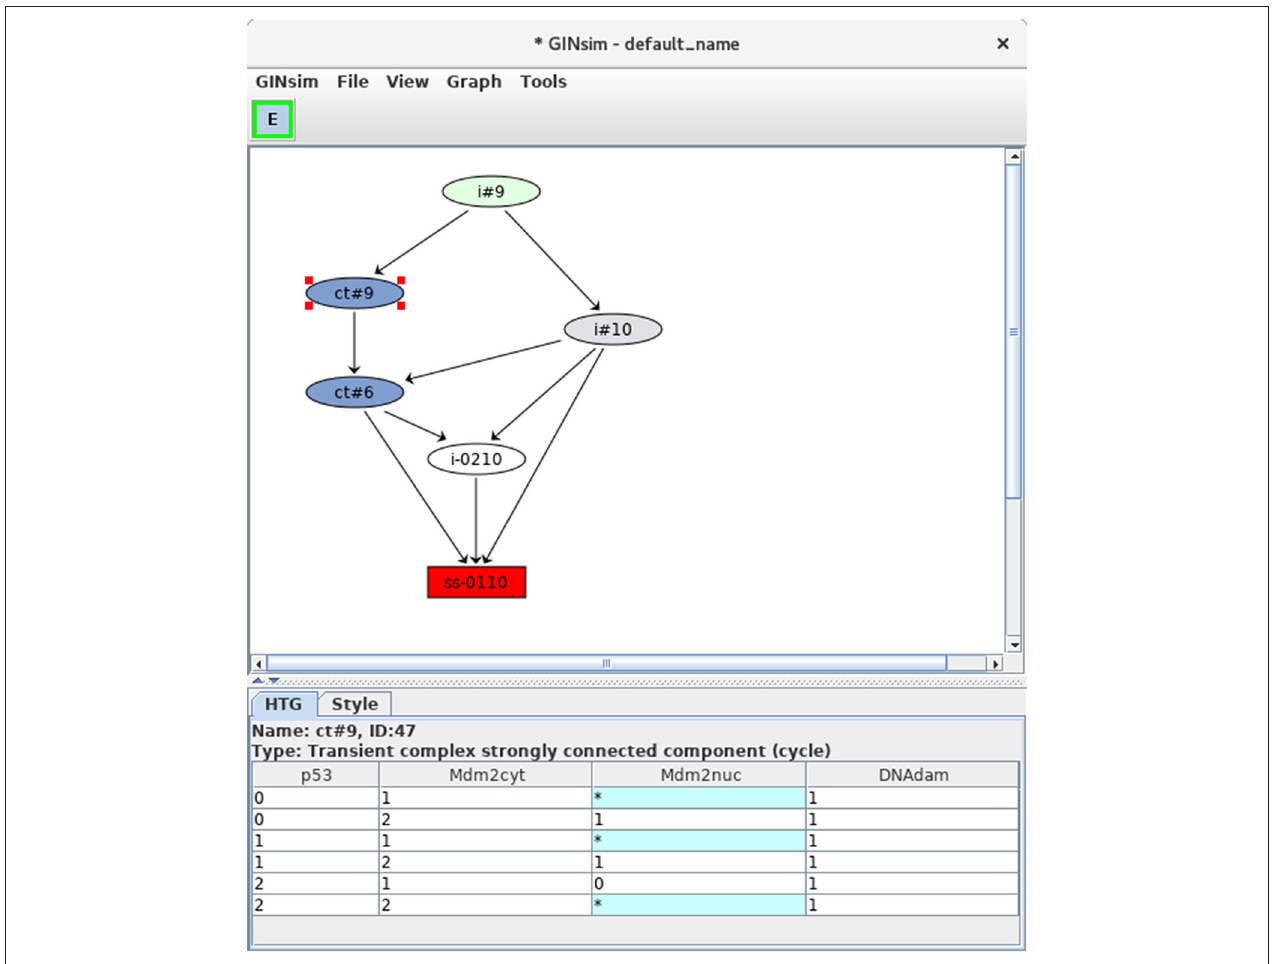
FIGURE 9 | Hierarchical transition graph. The hierarchical transition graph for the complete asynchronous dynamics of the p53-Mdm2 model is shown. It has been obtained by selecting the construction of Hierarchical Transition Graph in the corresponding scrolling menu when launching the simulation. Note that the layout has been manually improved. The blue nodes correspond to the two non trivial strongly connected components of the STG, and the unique stable state is shown in red at the bottom. The blue node labeled by ct#9 has been selected; this transient cyclic component encompasses nine states from the STG (as indicated by the #9 in its name), which are listed in the bottom. The * denotes all possible values for the corresponding node. Hence the first row in the table listing the states encompassed by the hypernode ct#9 corresponds to two states: 0101 and 0111